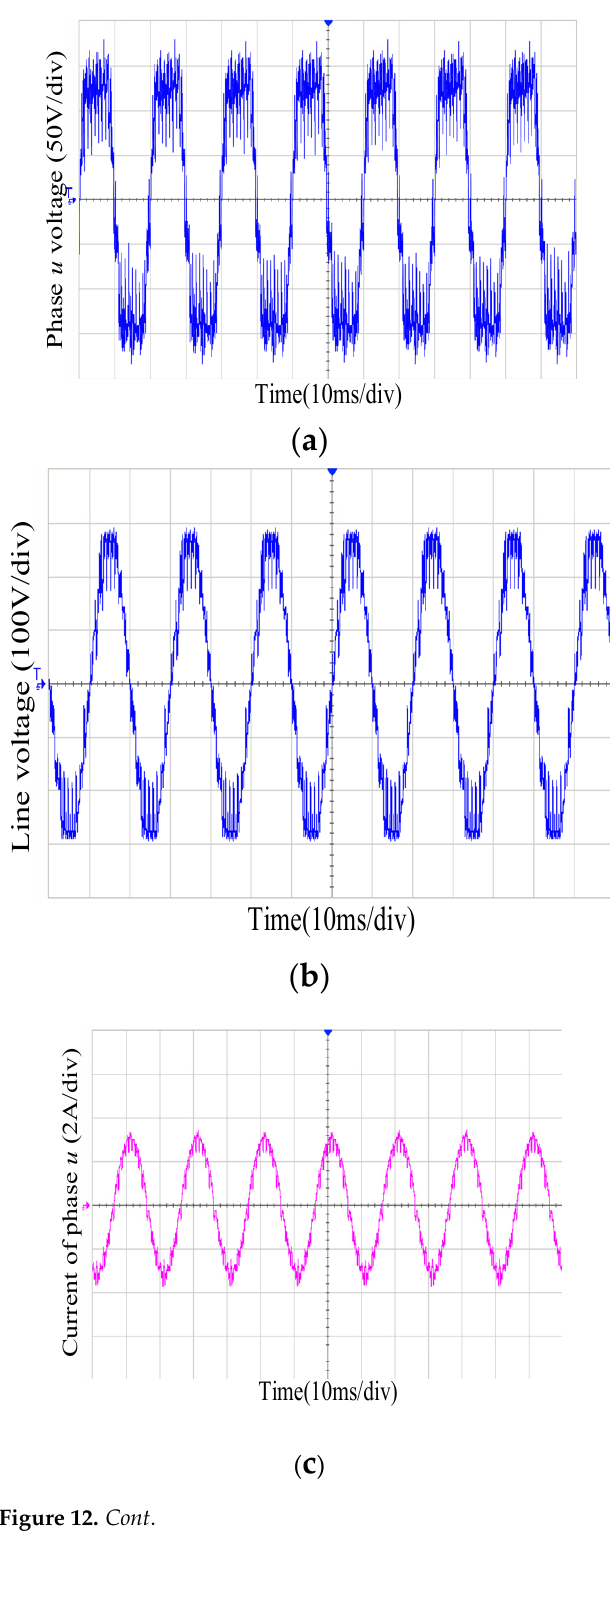
Figure 11. Experimental results under normal conditions ( a ) phase u voltage ( b ) line voltage u uv ( c ) current of phase u ( d ) some SM capacitor voltages of phase u and one zoomed-in curve.